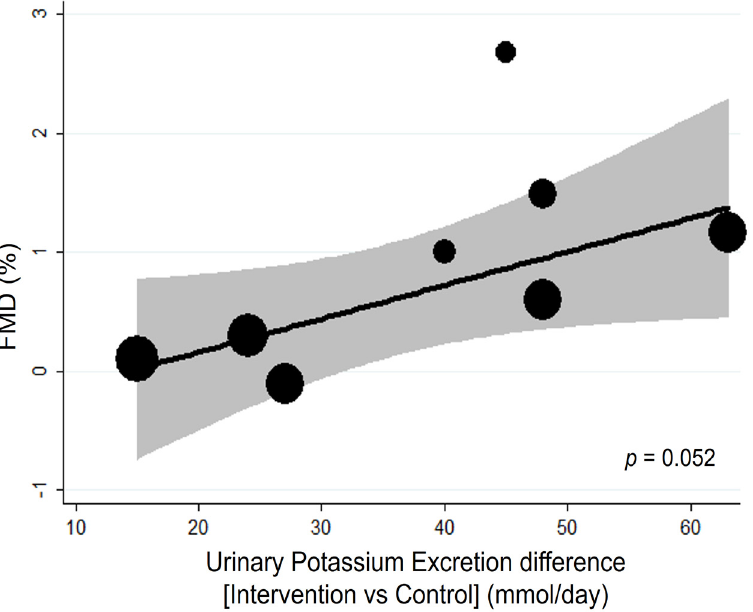
Figure 3. Bubble plot for random-effects meta-regression of mean difference (MD) in flow-mediated dilation (FMD) by potassium intake difference of the single studies. Bubbles each represent one study and are plotted according to the study’s MD and urinary potassium excretion of the single study; bubble sizes reflect the relative weight apportioned to studies in the random-effects meta-regression; the solid line indicates the line of best fit. Potassium supplementation is represented by urinary potassium excretion (mmol/day).